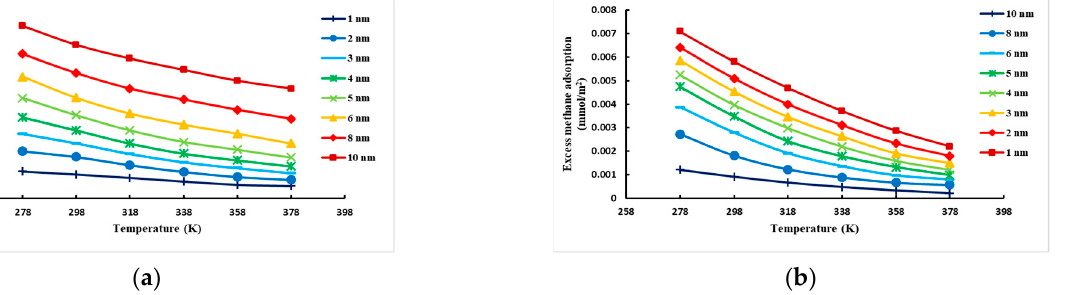
Figure 5. Methane adsorption capacity at different pore sizes ( a ): Total methane adsorption capacity, ( b ): Excess methane adsorption capacity.